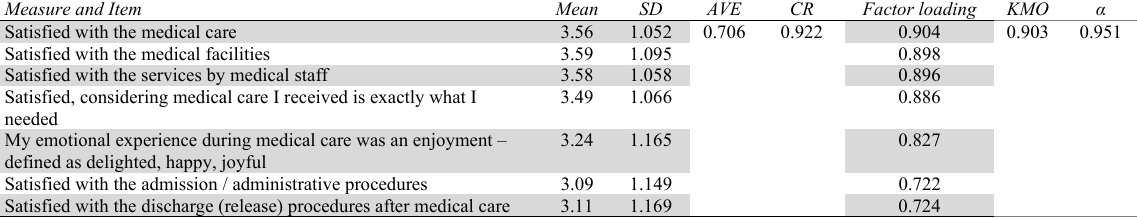
Customer Satisfaction scores Measure and